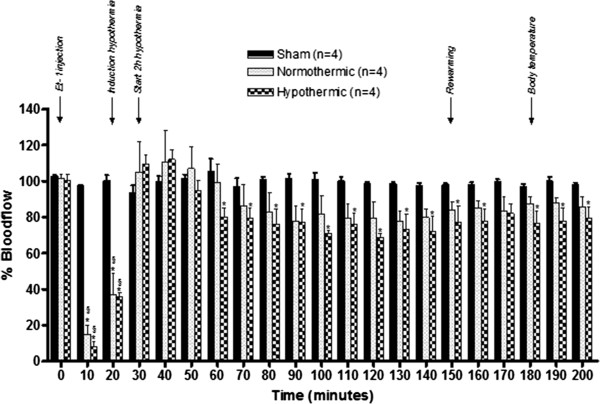
Effect of the hypothermic treatment on the CBF after injection of Et-1. The graph shows the percentage increase or decrease in CBF in sham, normothermic or hypothermic animals (n = 4 in each group), compared to basal values (equal to 100%) which were assessed before injection of Et-1 or vehicle. The hypothermia treatment in the Et-1 model does not affect the CBF. *Significantly different (p < 0.05) from the time point 0 min. §Significantly different (p < 0.05) compared to the sham group.